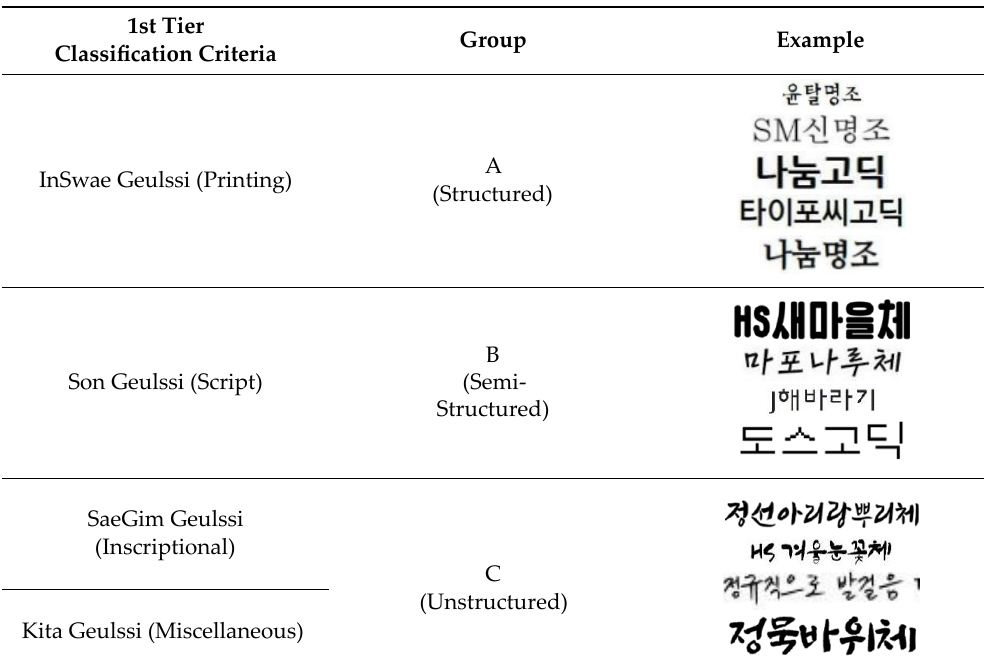
Table 3. Structured (A), semi‑structured (B), and unstructured (C) font groups according to font classification